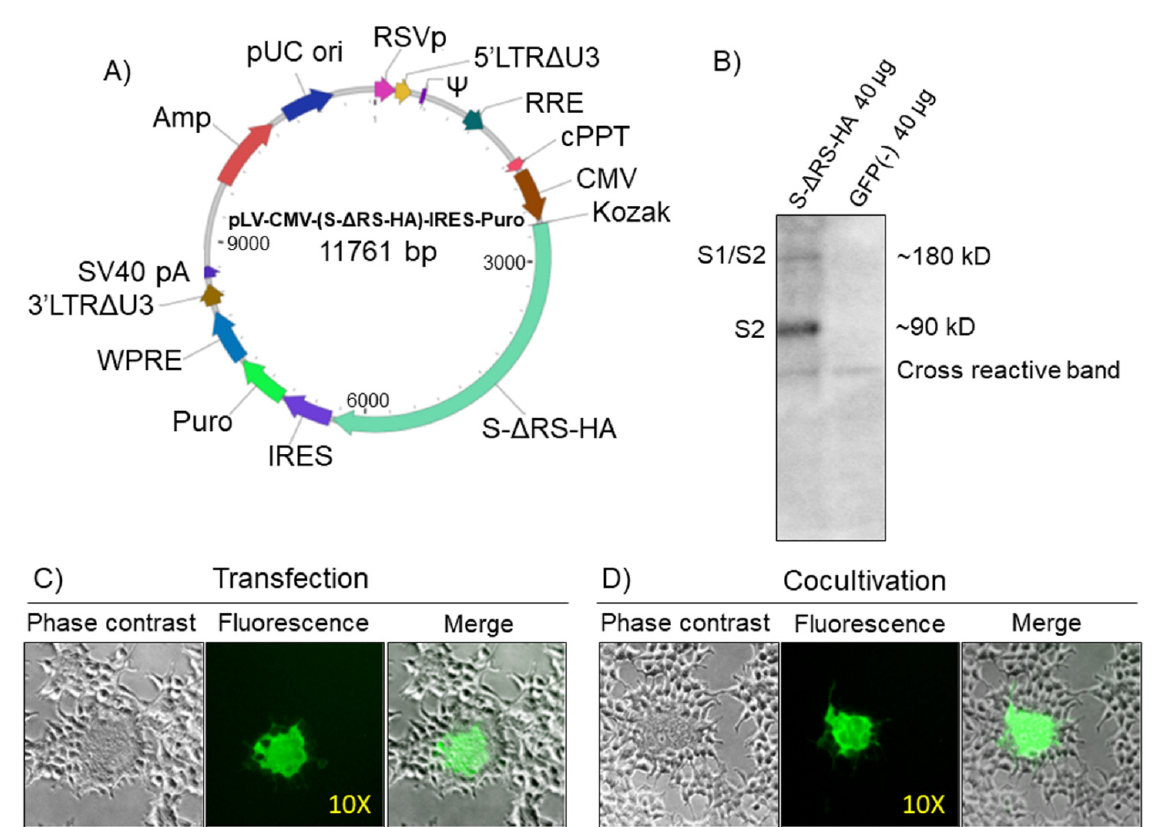
Figure 1. CoV-2 S expression in HEK293T cells. ( A ) Diagram (not to scale) of pLV-CMV-(S- ∆ RS-HA)-IRES-Puro-WPRE transfer vector, where functional elements of the construct are indicated and highlighted with different colors. RSVp (Rous sarcoma virus enhancer/promoter), 5 (cid:48) LTR ∆ U3 (truncated HIV-1 5 (cid:48) long terminal repeat), Ψ (HIV-1 packaging signal), RRE (HIV-1 REV response element), cPPT (central polypurine tract), CMV (human cytomegalovirus immediate early enhancer/promoter), Kozak (Kozak’s translation initiation sequence), S- ∆ RS-HA (human codon usage adapted, HA-tagged and retention-signal-deleted CoV-2 S ORF), IRES (encephalomyocarditis virus internal ribosomal entry site), Puro (puromycin-resistant gene ORF), WPRE (woodchuck hepatitis virus posttranslational regulatory element), 3 (cid:48) LTR ∆ U3 (truncated HIV-1 3 (cid:48) long terminal repeat; self-inactivation), SV40 early pA (simian virus 40 early polyadenylation signal), Amp (ampicillin resistance gene, comprising the promoter and ORF) and pUC ori (high-copy-number pUC origin of replication). ( B ) Western immunoblotting of pLV-CMV-(S- ∆ RS-HA)-IRES-Puro-WPRE transfected HEK293T cell protein extracts (S- ∆ RS-HA; 40 and 20 µ g) and pEGFP-C1 transfected HEK293T cell protein extract (GFP; 40 µ g) employed as a negative control (-). Cross-reactive bands in both lanes indicate the loading. ( C ) Representative microscopic image (phase contrast, fluorescence, and merged fields; 10X) of syncytia, generated by cotransfection of HEK/ACE2/TMPRRS2/Puro cells with pLV-CMV-(S- ∆ RS-HA)-IRES-Puro-WPRE construct and PEGFP-C1. ( D ) Representative microscopic image (phase contrast, fluorescence, and merged fields; 10X) of syncytia, generated by cocultivation of HEK/ACE2/TMPRRS2/Puro cells with pLV-CMV-(S- ∆ RS-HA)-IRES-Puro-WPRE and pEGFP-C1 cotransiently transfected HEK293T